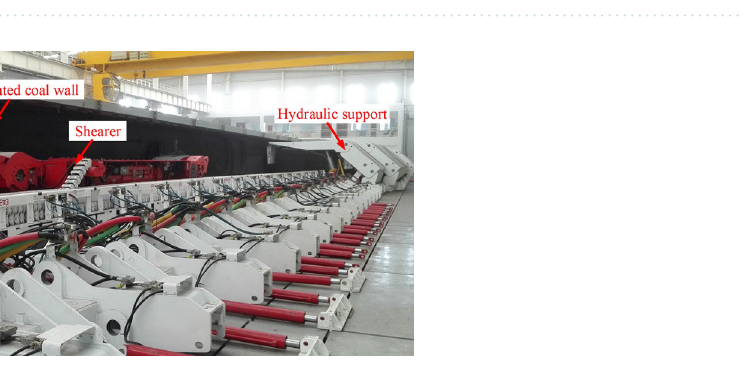
Figure 8. Vibration displacement of key parts of the shearer under different working conditions: under varied ( a ) traction speeds, ( b ) hardness values of coal rock and ( c ) pitch angles.